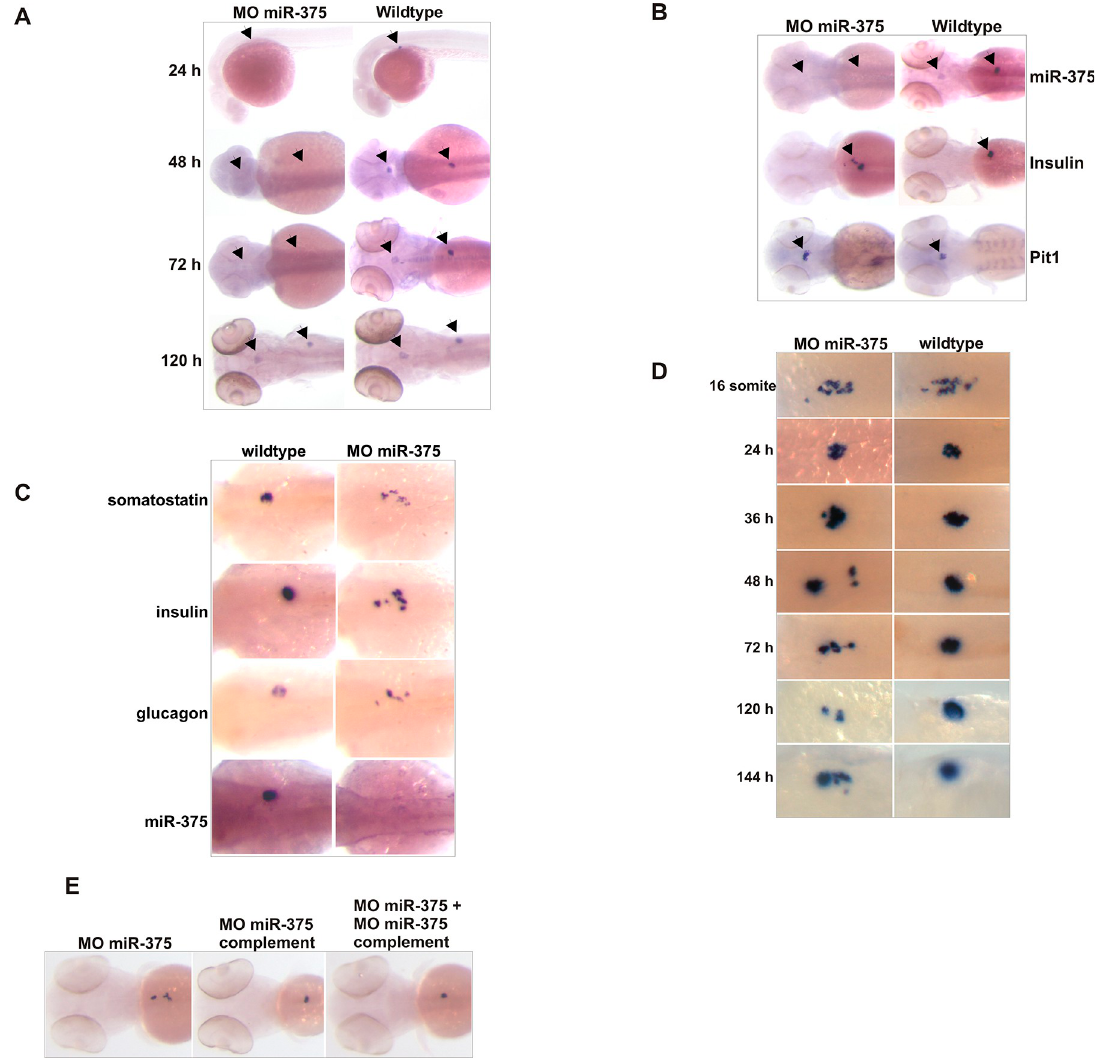
Fig 5. Knockdown of miR-375 Results in Aberrant Migration of Pancreatic Islet Cells. (A) In situ analysis of miR-375 knockdown in MO miR-375–injected embryos and noninjected controls at 24, 48, 72, and 120 hpf. Arrowheads indicate the pituitary gland and the pancreatic islet. (B) In situ analysis of the pancreatic islet (insulin staining) and the pituitary gland (pit1 staining) in miR-375 morphants and noninjected controls. Arrowheads indicate the pituitary gland and the pancreatic islet. (C) In situ analysis of pancreatic islet development in wild-type and morphant embryos using insulin, somatostatin, and glucagon as markers. (D) Time series of insulin expression in wild-type and morphant embryos injected with MO miR-375. The WT 72h panel of Fig 5D is identical to the WT insulin panel of Fig 6A, due to these panels representing the same experimental condition. (E) Insulin expression in 72-hpf embryos injected with MO miR-375 and a complementary morpholino.